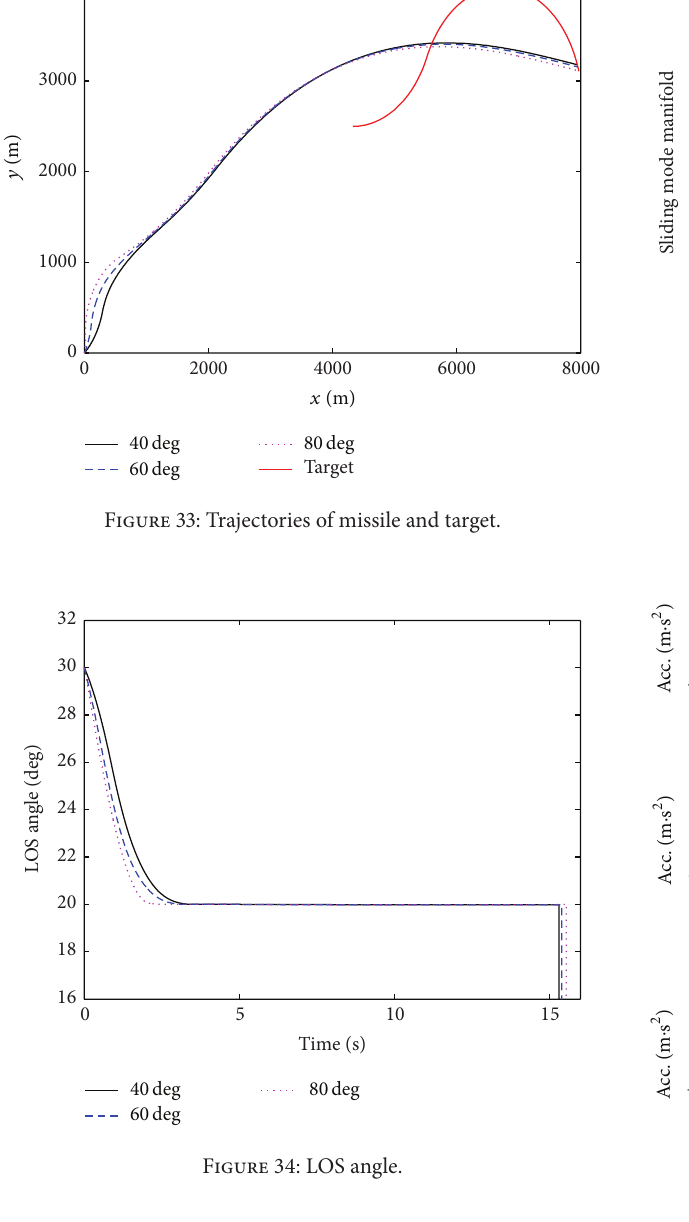
Figure 36: Missile